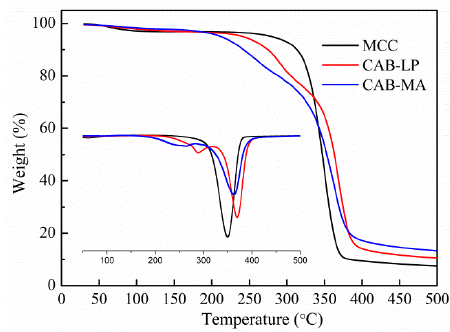
Figure 5. Thermogravimetric analysis (TGA) and derivative thermogravimetry (DTG) curves of MCC and CAB.